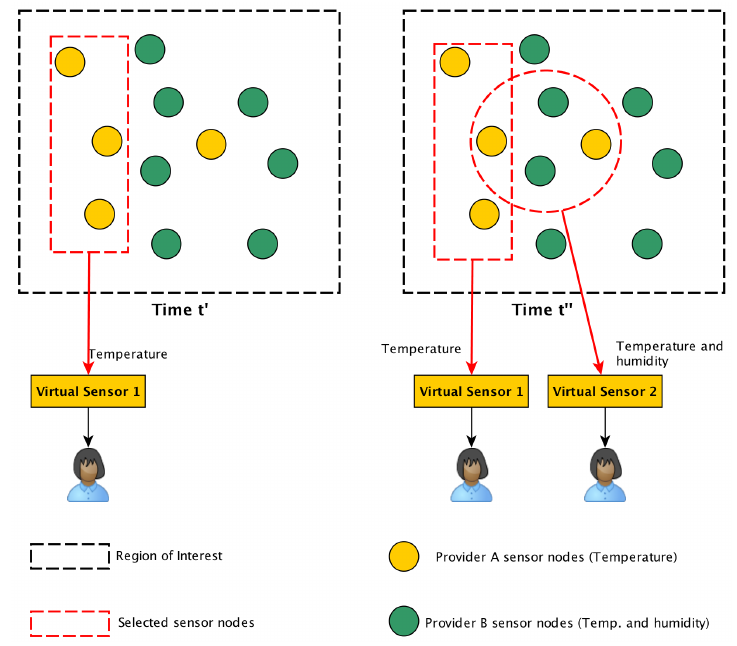
Figure 2. An example of